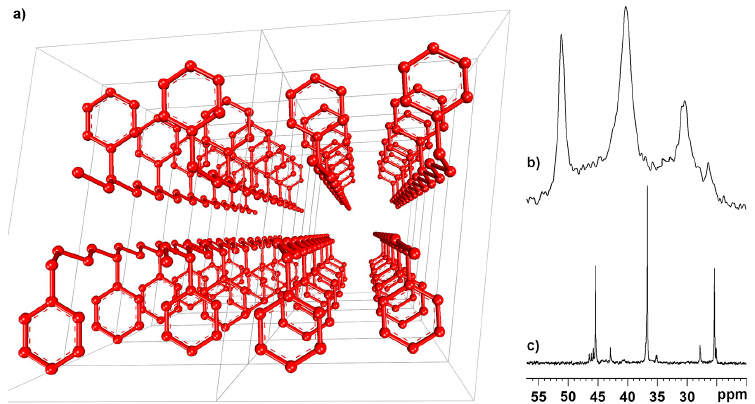
Figure 2. Crystalline structure of isotactic poly(ethylene- alt -styrene) copolymer ( a ); cross-polarization magic-angle spinning (CP-MAS) 13 C-NMR ( b ); and solution 13 C ( c ) spectra of the aliphatic region of the same copolymer.